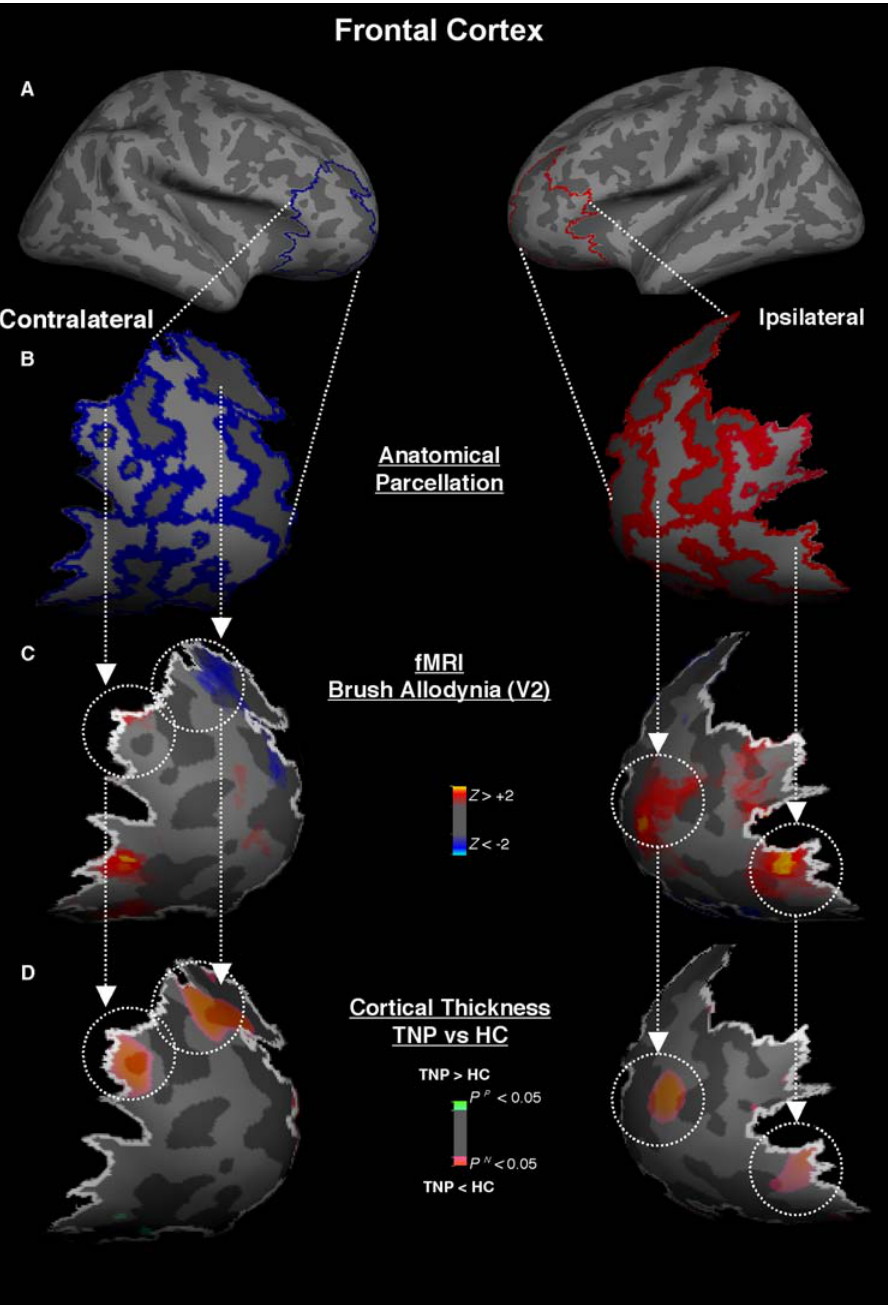
Figure 3. Frontal Cortex (Lateral). Panel A and B - The latero-frontal cortex was parcellated in seven sections. Panel C - BOLD (de)activation following allodynic brush stimulation in TNP patients showed bilateral activation in the frontal middle, and inferior gyri that extended in part to the frontomarginal cortex, as well as deactivation in the contralateral superior frontal sulcus. There was also bilateral activation in the posterior orbital gyrus. Panel D –Most of the functional clusters of allodynic (de)activation were precisely colocalized with cortical thinning.